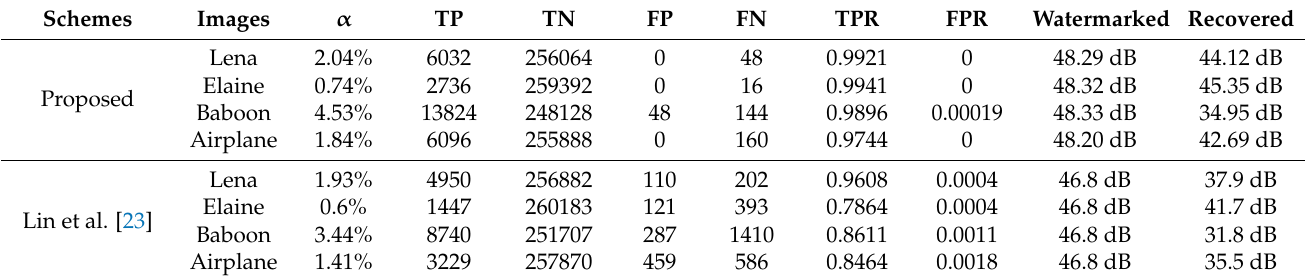
Table 7. Performance comparison with Lin et al.’s AMBTC-based scheme